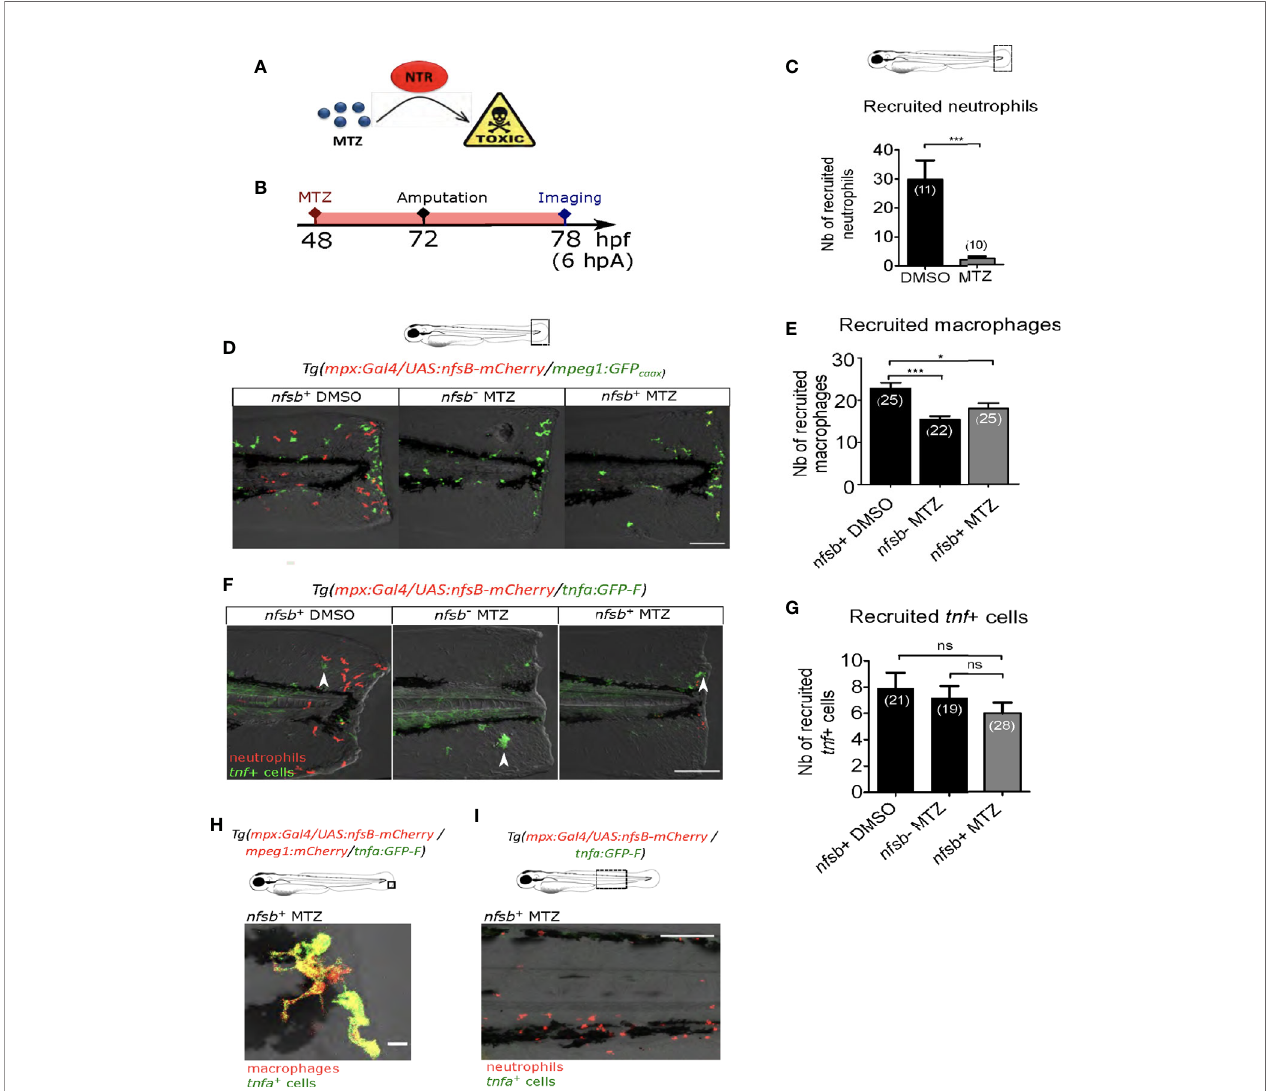
FIGURE 4 | Neutrophil presence at the wound is not necessary for macrophage activation. (A) Mechanism of action of the prodrug metronidazole (MTZ) that is converted into a cell-autonomous toxic molecule in the presence of nitroreductase (NTR). Speci fi c expression of NTR within neutrophils leads to the depletion and immobilization of larval neutrophils. (B) Schedule of the experiment. At 48 hpf Tg(mpx:Gal4/UAS:nfsB-mCherry/tnfa:GFP-F) or Tg(mpx:Gal4/UAS:nfsB-mCherry/ mpeg1:GFP-caax) larvae were treated with metronidazole (MTZ) and maintained in the drug until the end of the experiment. Transgenic larvae treated with DMSO and WT siblings treated with MTZ were used as controls. At 3 dpf, fi n folds were injured and larvae were imaged at 6 hpA using confocal microscopy. (C) Quanti fi cation of recruited neutrophils at the wound at 6 hpA, after the treatment with MTZ or DMSO. Representative experiment of three independent experiments, mean ± SEM, n larvae is indicated in brackets, one-tailed t-test with Welch ’ s correction, ***p<0.001. (D) Tg(mpx:Gal4/UAS:nfsB-mCherry/mpeg1:GFP-caax) treated with DMSO ( nfsb + DMSO) or with MTZ ( nfsb + MTZ) and WT siblings with MTZ ( nfsb - MTZ). Tail images are representative maximum projections of the fl uorescence of mCherry-F (neutrophils), GFP-caax (macrophages) and merged channel images with bright fi eld at 6 hpA. Scale bar: 100 m m. (E) Quanti fi cation of recruited macrophages at the wound at 6 hpA, after the treatment with MTZ or DMSO. Representative experiment of two independent experiments, mean ± SEM, n larvae is indicated in brackets, upper graph: one-way ANOVA, *p<0.05 ***p<0.001. (F) Tg(mpx:Gal4/UAS:nfsB-mCherry/tnfa:GFP-F) treated with DMSO ( nfsb + DMSO) or with MTZ ( nfsb + MTZ + ) and WT siblings with MTZ ( nfsb - MTZ + ). Tail images are representative maximum projections of the fl uorescence of mCherry-F (neutrophils), GFP-F (tnfa+ cells, selected by arrow heads) and merged channel images with bright fi eld at 6 hpA. Scale bar: 100 m m. (G) Quanti fi cation of recruited tnfa + cells at the wound at 6 hpA in indicated conditions. Two independent experiments merged, mean ± SEM, n larvae is indicated in brackets, Kruskal-Wallis test, ns: not signi fi cant. (H) Quadruple transgenic line Tg(mpx:Gal4/UAS:nfsB-mCherry/mfap4:mCherry/tnfa:GFP-F) treated with MTZ and imaged at 6hpA. Image is the representative zoomed and overlaid maximum projections showing the overlap of the fl uorescence of mCherry-F (macrophages) and GFP-F ( tnfa + cells), in the absence of neutrophils at the wound. Scale bar: 10 m m. (I) Tg(mpx:Gal4/UAS:nfsB-mCherry/tnfa:GFP-F) larvae treated with MTZ and imaged at 6hpA in the CHT region. Image is a representative maximum projection of mCherry and GFP-F fl uorescences overlaid with bright fi eld image, showing no potential tnfa (GFP-F + cells) expressed in the vicinity of neutrophils (mCherry + cells) upon MTZ treatment. Scale bar: 100 m